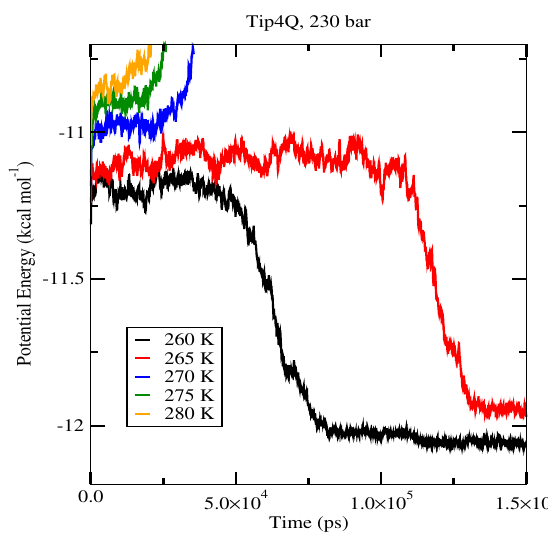
Figure 8. Evolution in time of the potential energy in simulations with the TIP4Q model of the system in Figure 12.